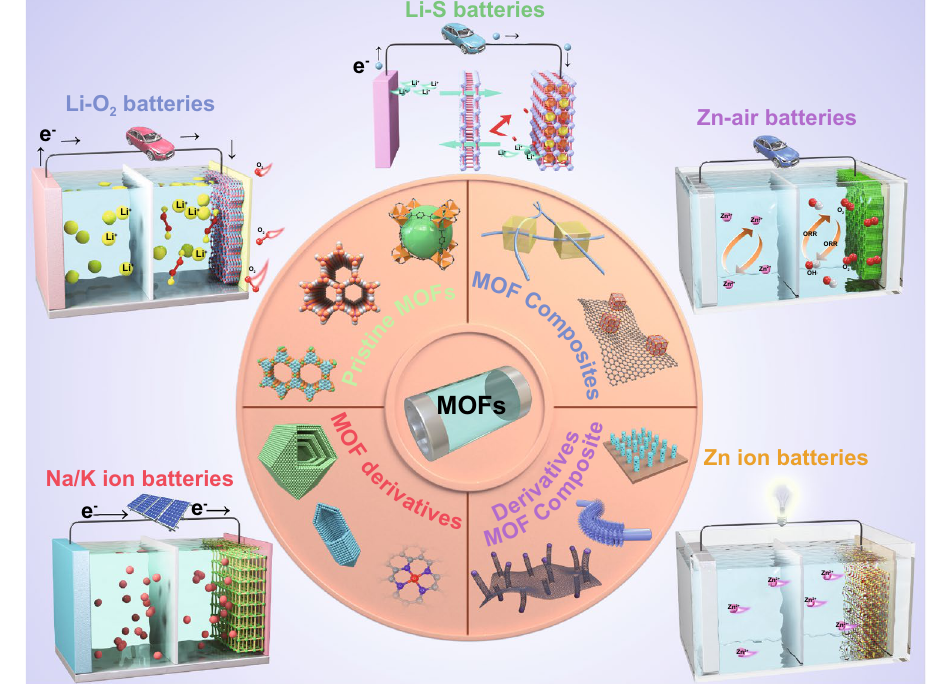
Fig. 1 Schematic illustration of MOF-related materials for next-generation